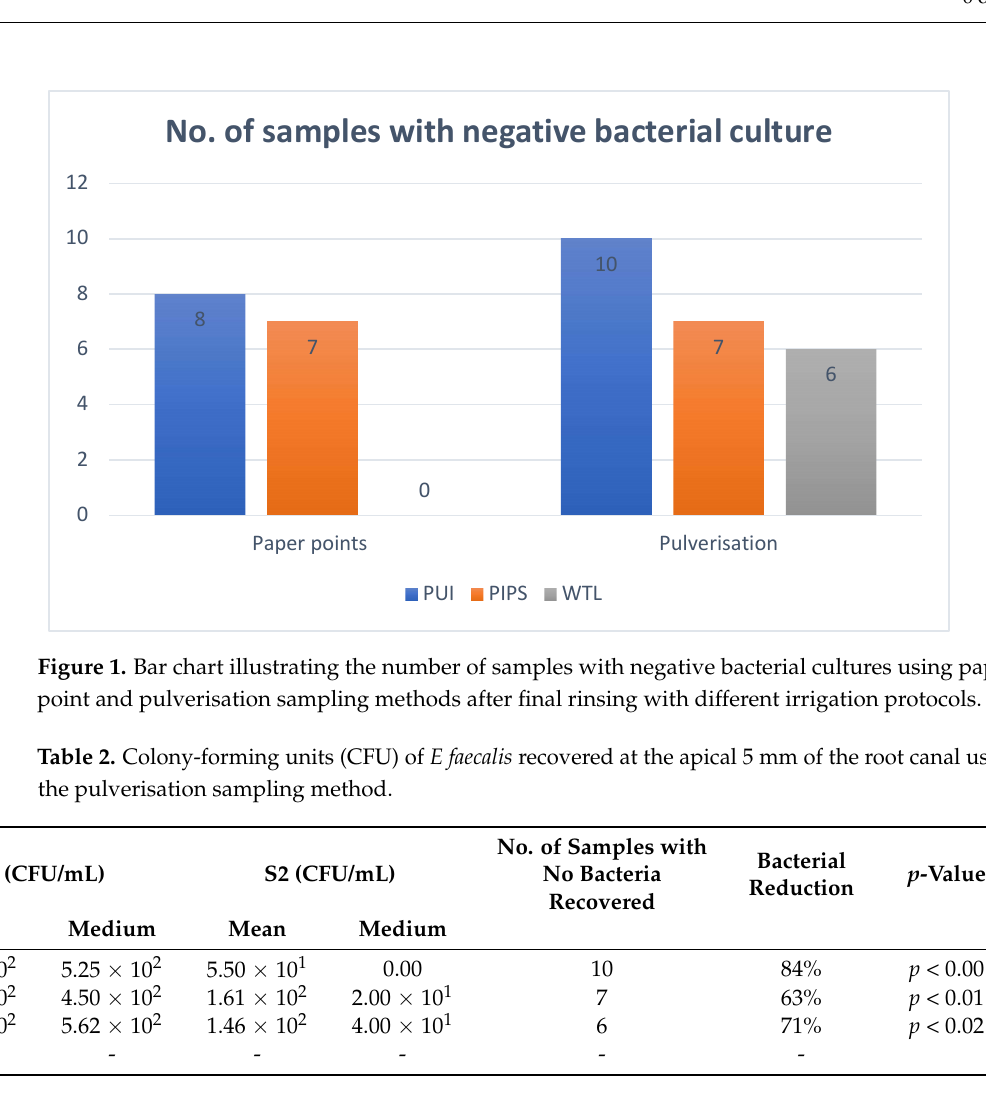
The mean CFU/mL value of S1 and S2 for the WTL group was 3.83 × 10 5